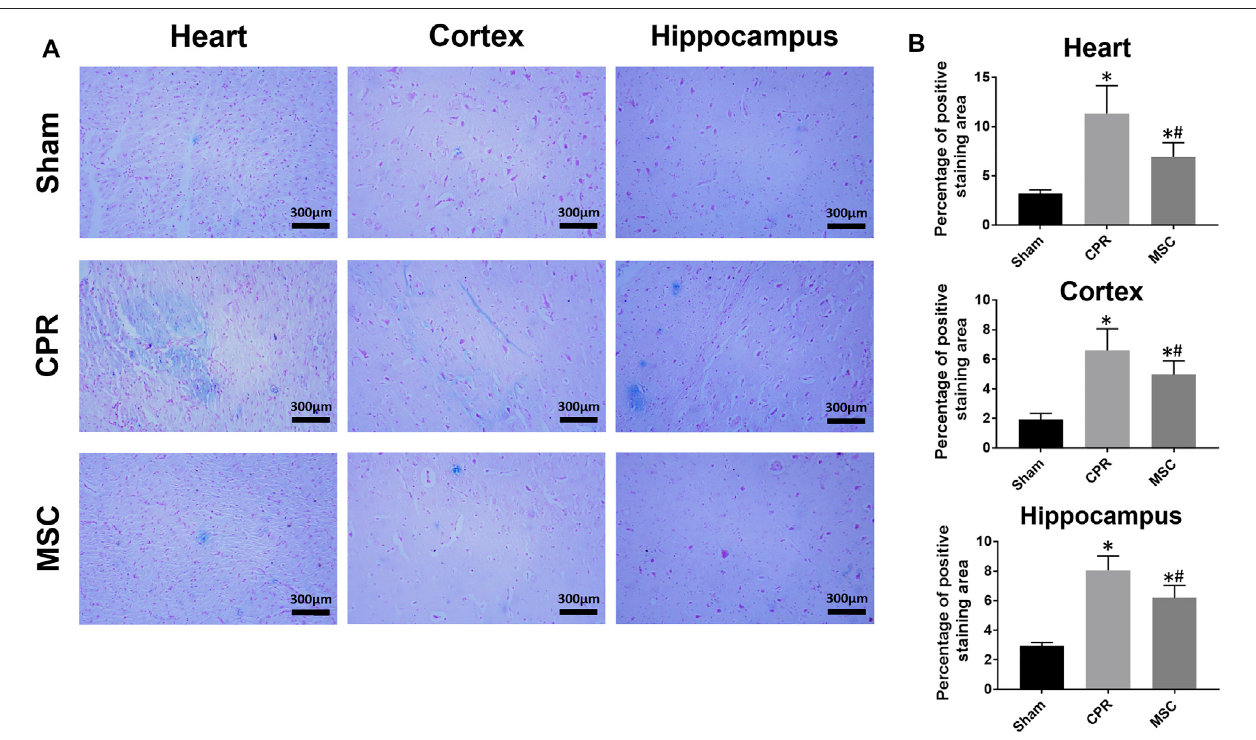
FIGURE 9 | Iron deposition in the heart, cortex and hippocampus (A) Representative photomicrographs of Prussian blue staining ( × 200magni fi cation) (B) The percentage of positive staining area. CPR, cardiopulmonary resuscitation; MSC, mesenchymal stem cell. * p < 0.05 versus sham group; # p < 0.05 versus CPR group.